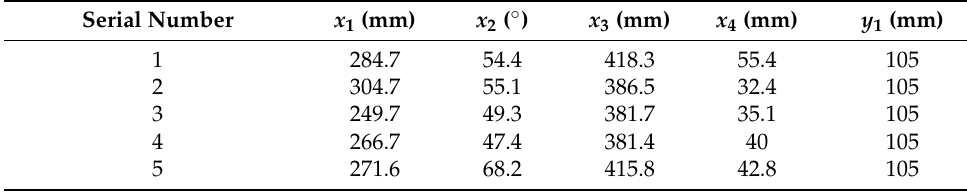
Table 6. Variance analysis of the test results.